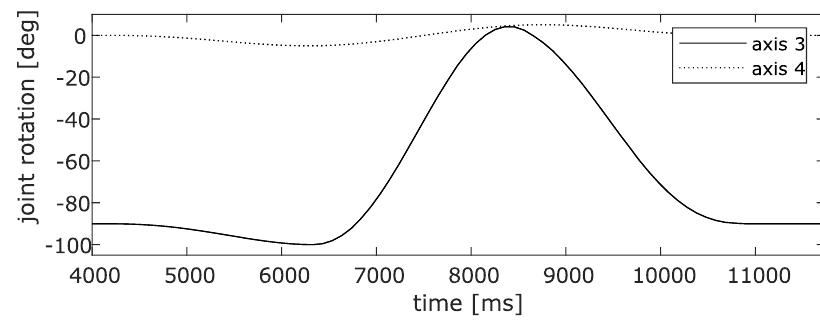
Figure 4. Angles Applied to the